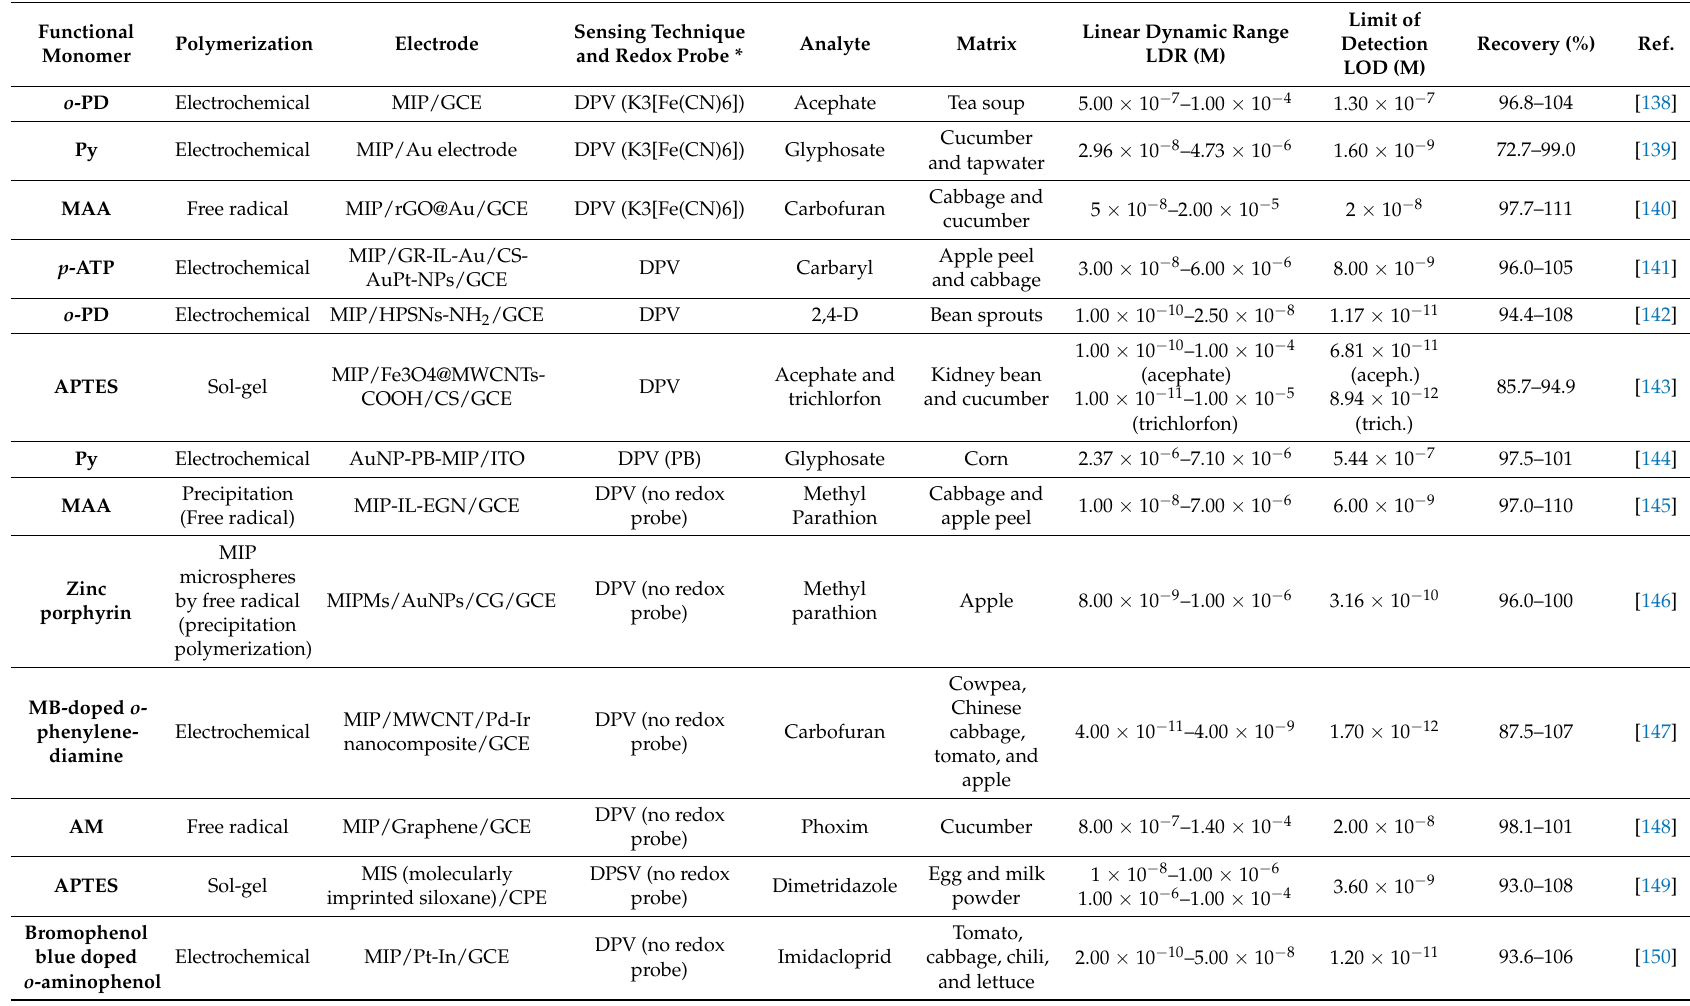
Table 5. Electrochemical MIP sensors for pesticides detection in food: main features and